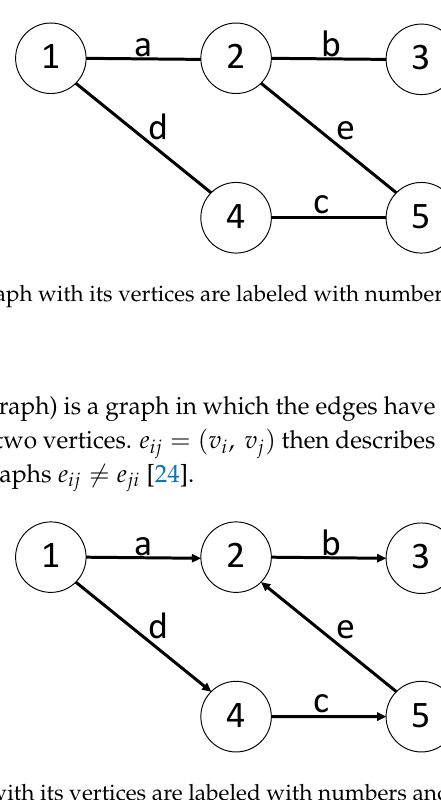
Figure 3. Directed graph with its vertices are labeled with numbers and its edges with letters. Edges show arrows to visualize their direction, e.g., a is the edge from vertex 1 to vertex 2.